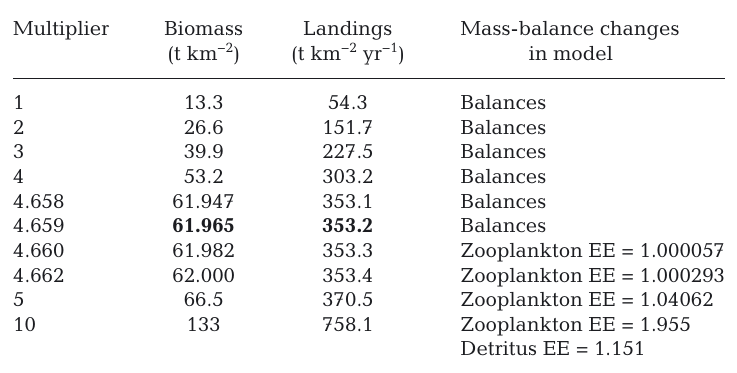
Table 3. Changes in the Yellow River Estuary ecoregion Ecopath model while estimating carrying capacity using the automated mass-balancing routine. Numbers in bold type are the calculated ecological carrying capacity biomass values for cultured bivalves (Group 17) and their landings. Landings are the predicted amount of harvest when the ecotrophic efficiency (EE) of cultured bivalves equals 0.95. Any biomass value below the carrying capacity did not affect the balanced model. Any biomass value above the carrying capacity re- sulted in an unbalanced model as it led to the EE of another group or